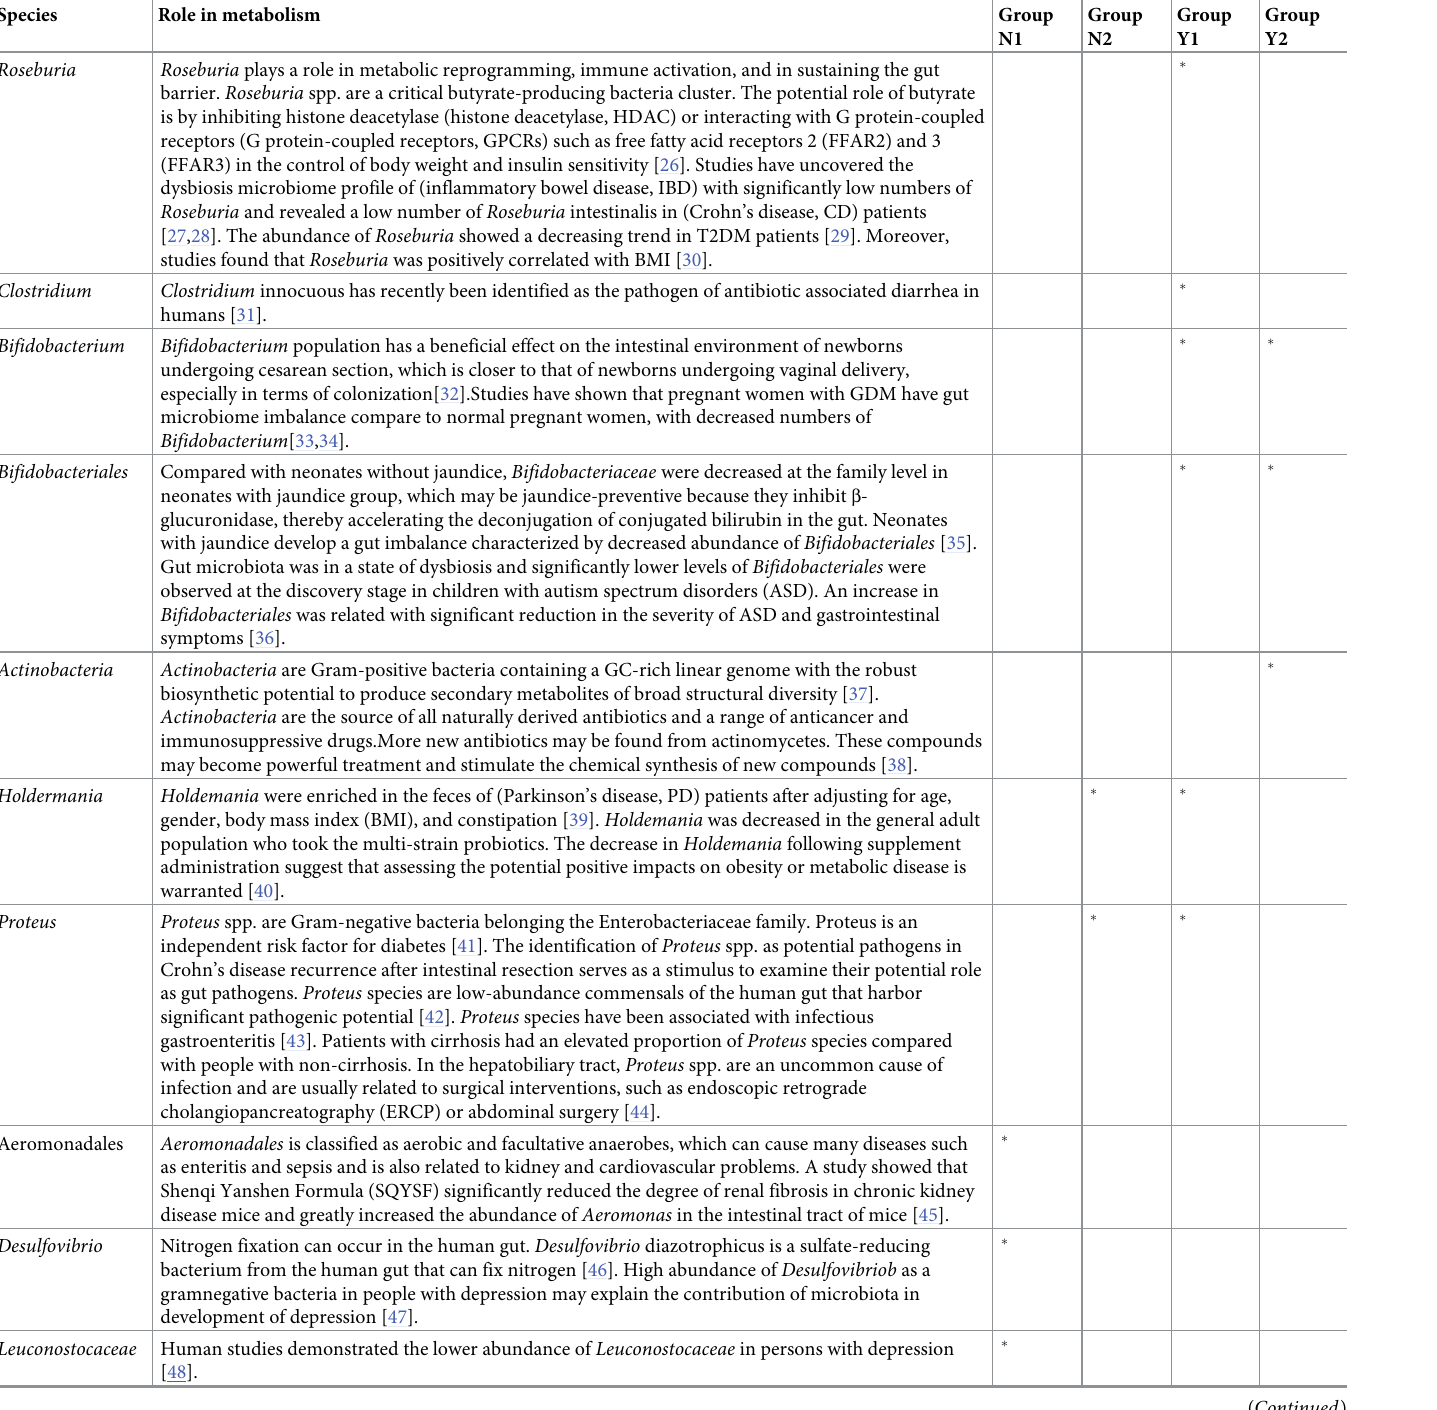
Table 4. Comparison of different species enriched in effective groups and ineffective groups.